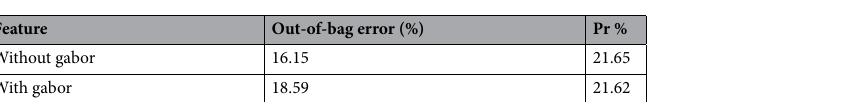
Table 1. Out-of-bag error (super). Out-of-bag error results from the random forest classifier and percentage of right segmented pixels (PR) in the whole image for the super-objects.